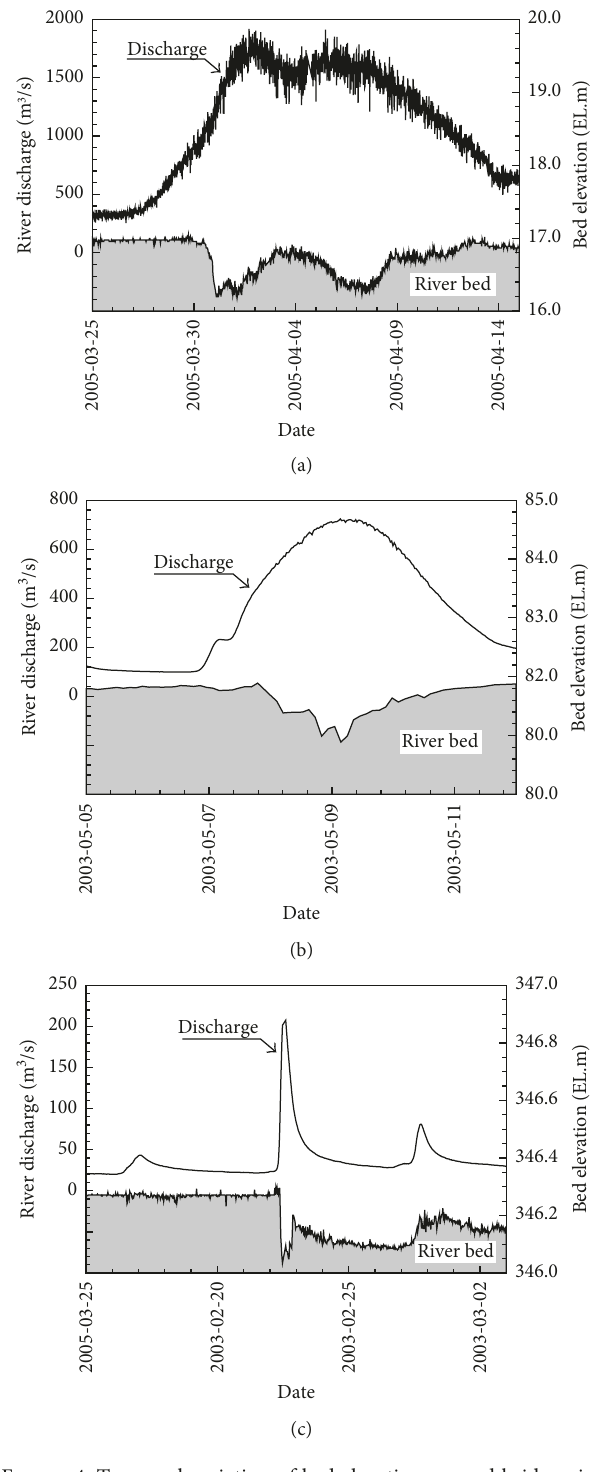
Figure 4: Temporal variation of bed elevation around bridge pier bent with corresponding discharge in (a) Flint River, (b) Chatta- hoochee River, and (c) Ocmulgee